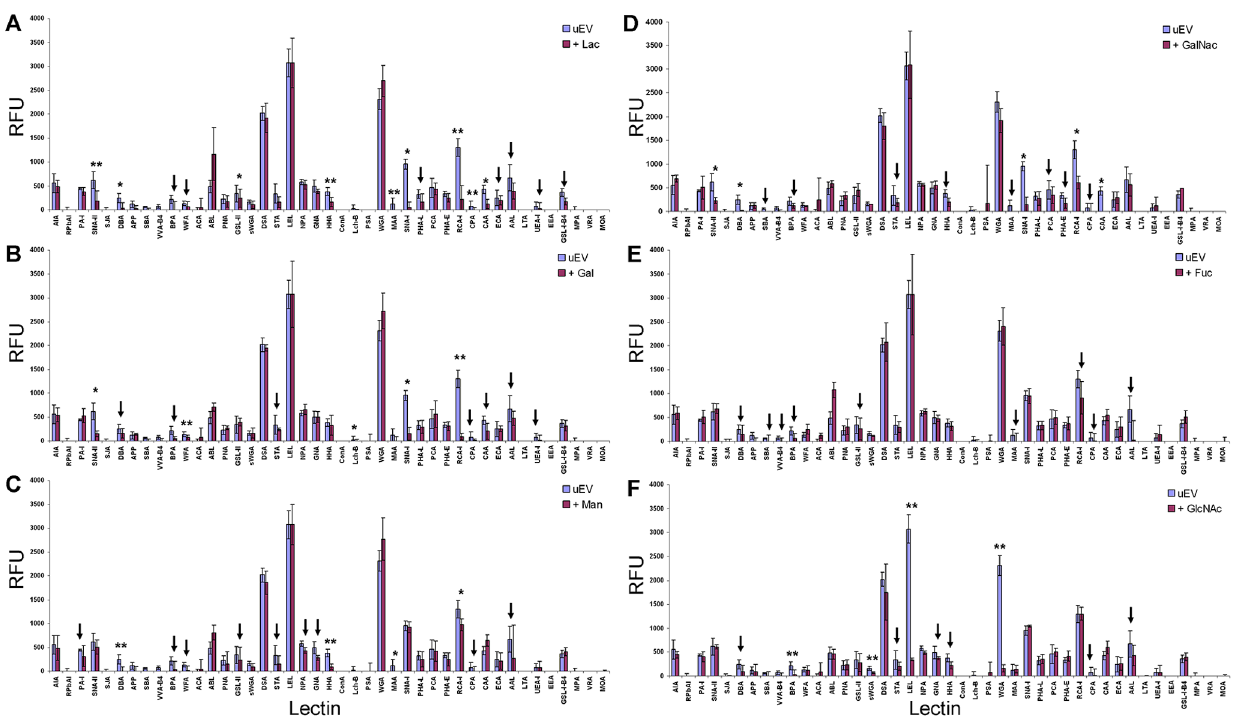
Figure 6. Competitive inhibition of uEV interactions with lectin microarray using six different sugars. Data normalized to the response of LEL to show the relative inhibition through competition with 50 mM concentrations of ( A ) Lac, ( B ) Gal, ( C ) Man, ( D ) GalNAc, and ( E ) and Fuc ( F ). To evaluate 50 mM GlcNAc inhibition ( F ), data was normalized to the response of RCA-I. Mean data is representative of inhibition for a single biological sample experiment conducted with 3 technical replicates. Error bars represent 6 average deviation. Significance (**= p # 0.01, *= p # 0.05) determined by two-tailed, two-sampled unequal variance Student’s t-test. Arrows mark reductions in intensity greater than 20% with p . 0.05.